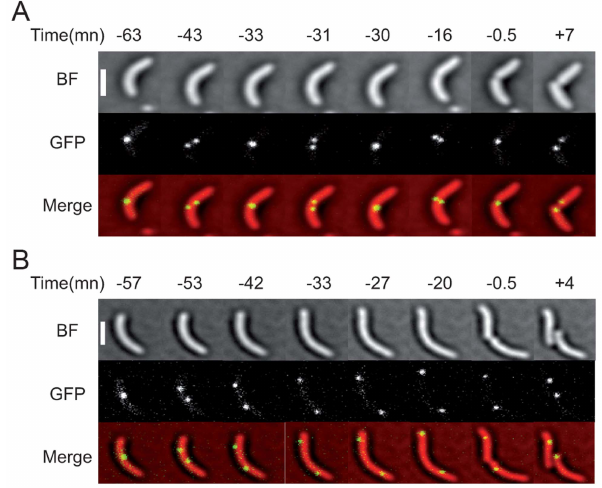
Figure 5. Two examples of the dif2 choreography observed by video microscopy. (A) WT cells. (B) matP 2 cells. The time before or after the cell division event is indicated in minutes. The phase images obtained from the BF images, the fluorescence images and the merge are shown. The scale bar corresponds to 2 m m. Other examples are presented in Movie S1 and